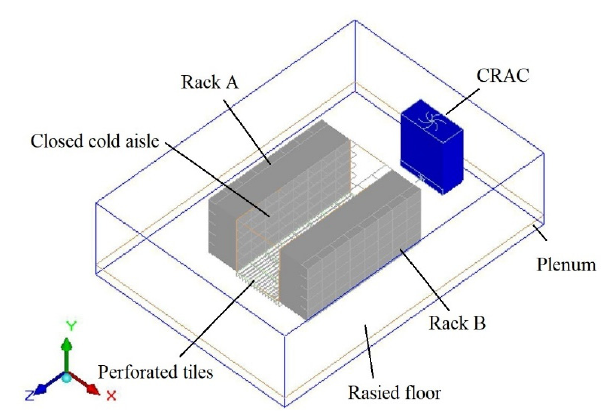
Figure 2. The 3D model of the data room.